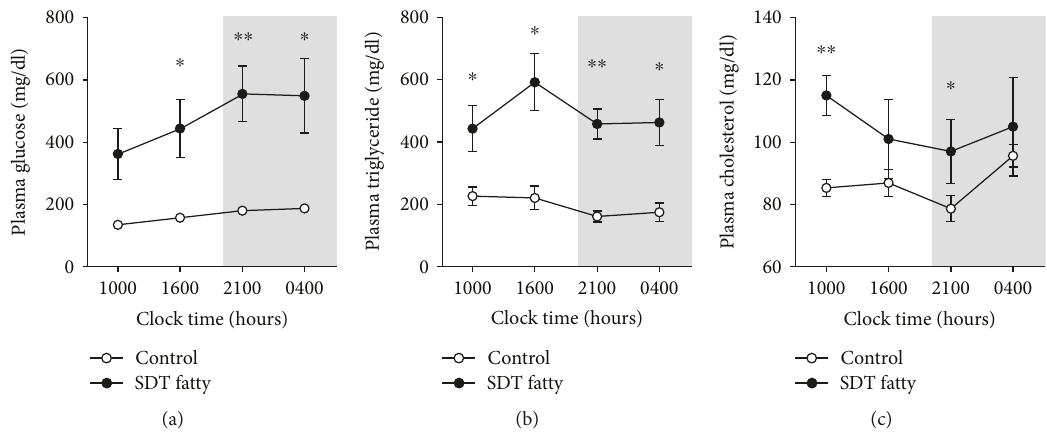
Figure 2: Circadian rhythms of plasma metabolic parameters in control Sprague – Dawley (SD) and Spontaneously Diabetic Torii (SDT) fatty rats: (a) glucose, (b) triglyceride, and (c) total cholesterol. Data are mean ± SEM ( n = 5 in each group). ∗ P < 0 05 and ∗∗ P < 0 01 compared with the control group at the same time point (two-way ANOVA with post hoc Aspin-Welch tests).